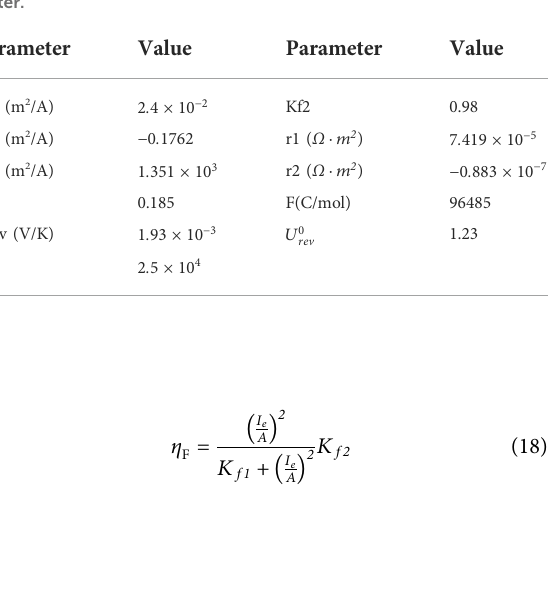
TABLE2Parametersrelatedtohydrogenproductionfromelectrolytic